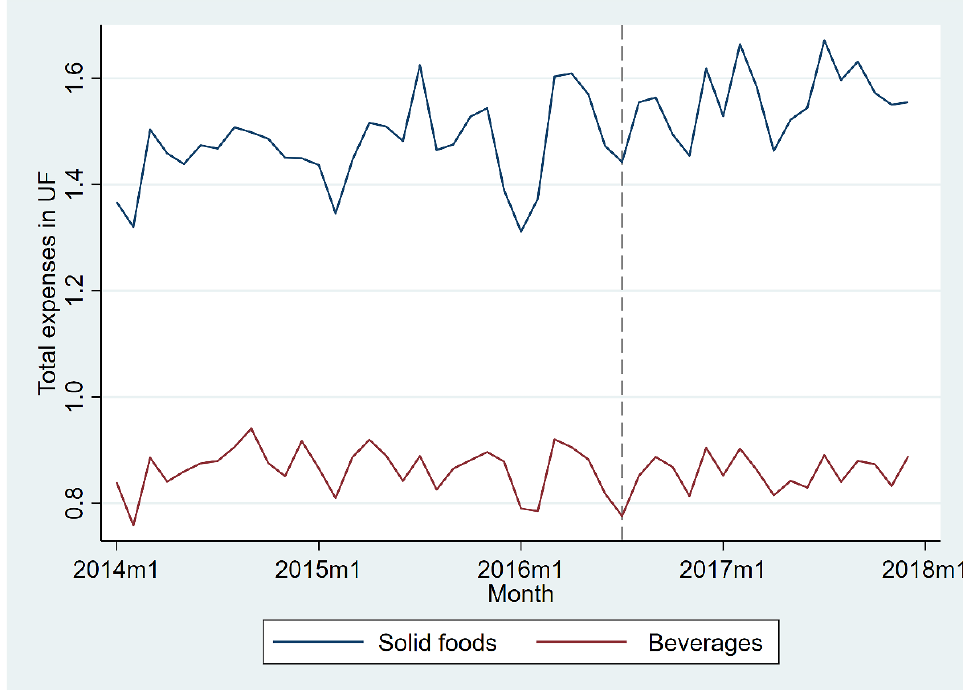
Figure 1. Total real expenditures allocated to foods and beverages.